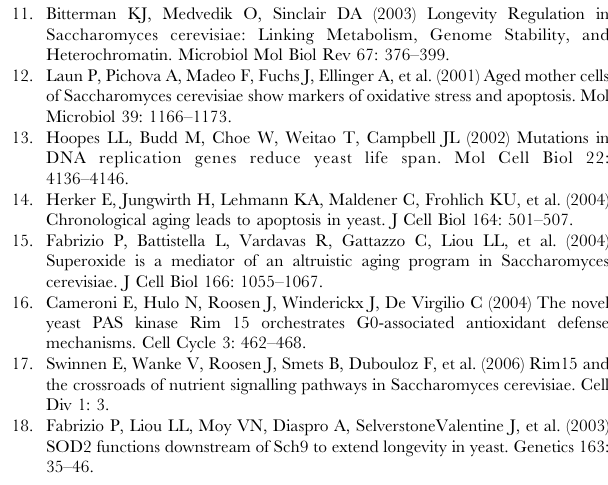
Figure S1 Chronological lifespan of sch9D compared to wild- type cells. Weinberger et al.